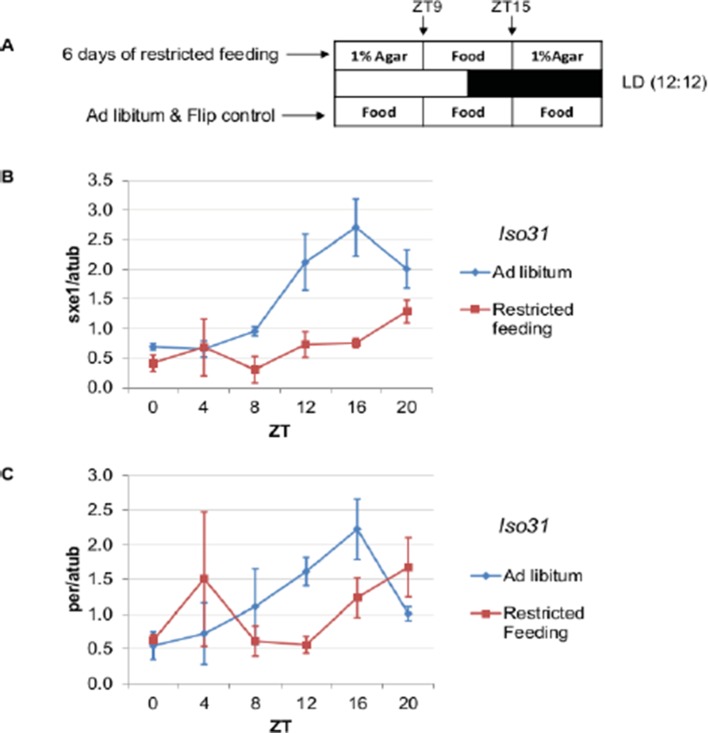
Restricted feeding between ZT9 and ZT15 alters the rhythmic expression of sxe1 and clock gene per in the Drosophila fat body.